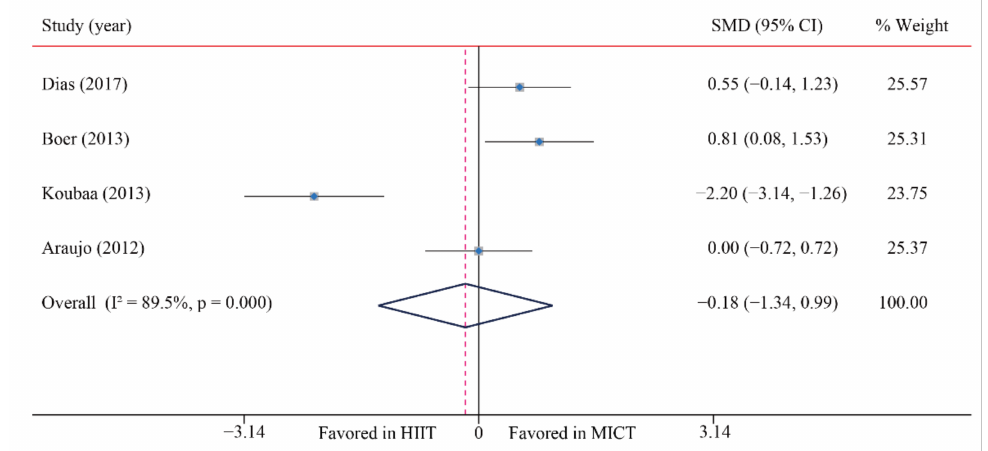
Figure 12. Effect of HIIT versus MICT on high-density lipoprotein cholesterol.